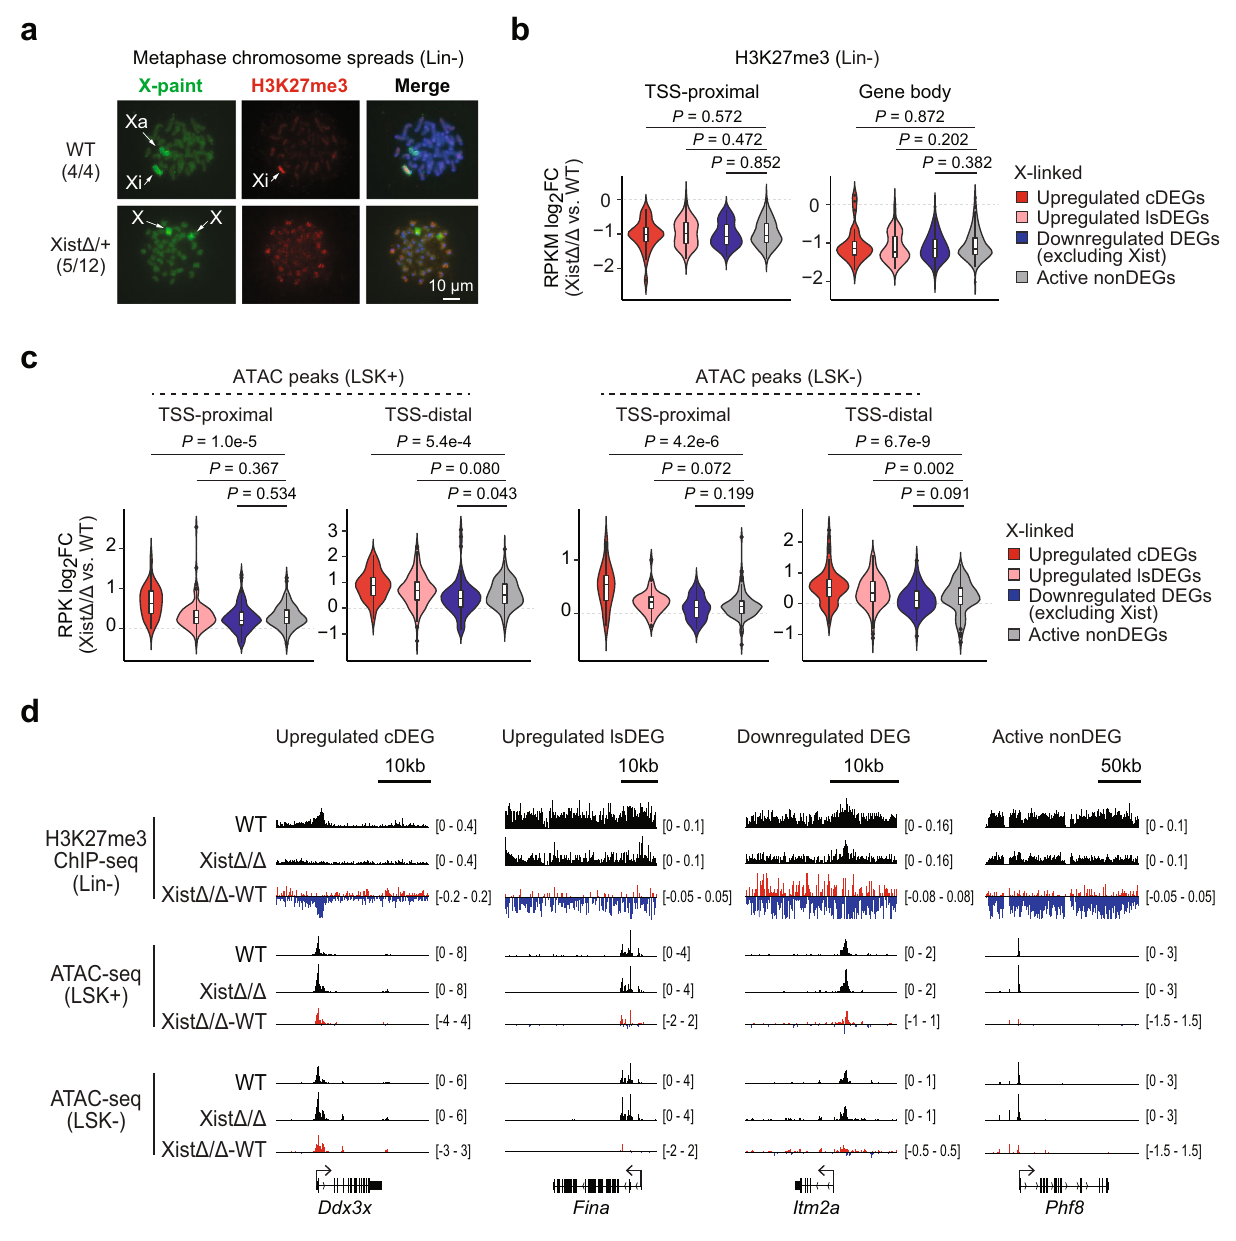
Fig. 4 | Transcriptional upregulation of X-linked genes is associated with increase in chromatin accessibility in Xist-de fi cient cells. a Representative images of sequential H3K27me3 IF staining and X-paint DNA FISH of metaphase chromosome spreads of Lin − cells isolated from WT and Xist Δ /+ female mice. The fractions of metaphase chromosome spreads with similar staining results are as indicated. b Violin and box plots show changes in H3K27me3 density within TSS- proximal and gene body regions of different types of DEGs as well as active non- DEGs on the X chromosome between Xist Δ / Δ and WT Lin − cells. RPKM, Reads Per Kilobase per Million mapped reads. c Violin and box plots show changes in ATAC peak intensity within TSS-proximal and TSS-distal regions of different types of